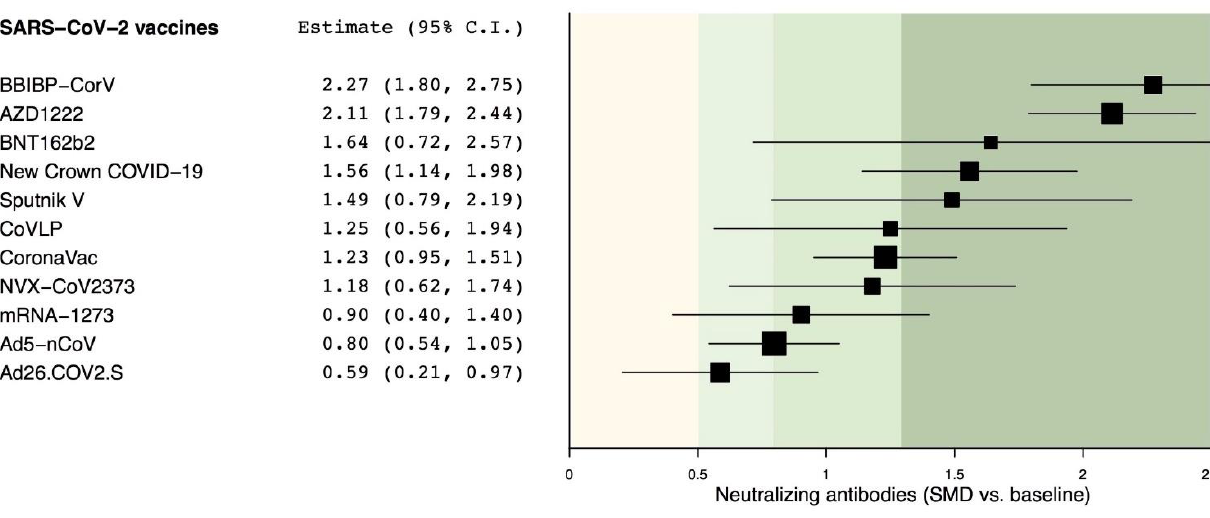
Figure 2. Overall forest plot of the impact of different candidate SARS-CoV-2 vaccines vs. baseline on the SMD in peak neutralizing antibodies. SARS-CoV-2 vaccine comparisons have been sorted in agreement with the level of efficacy; 95% CI: 95% confidence interval; SARS-CoV-2: severe acute respiratory syndrome coronavirus 2; SMD: standardized mean dif- ference.